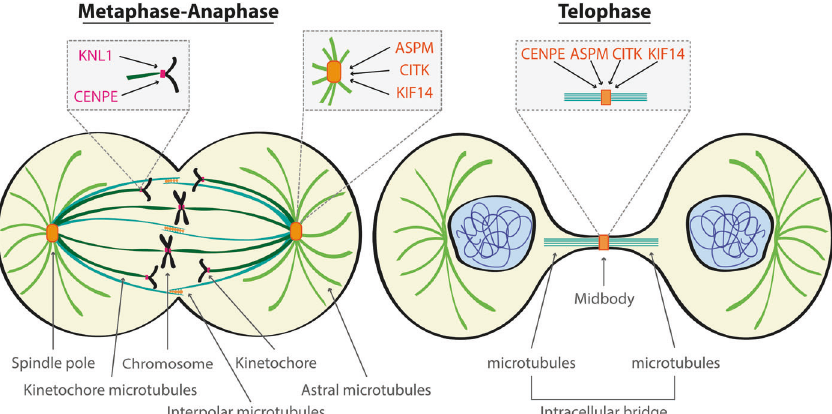
Fig. 1 Scheme of KNL1, ASPM, CENPE, CITK, and KIF14 localization during mitosis. During metaphase, KNL1 and CENPE are localized to kinetochore, where they promote microtubule-kinetochore attachment and correct chromosome alignment. KNL1 and CENPE remain localized to kinetochore up to anaphase. During metaphase-anaphase transition, ASPM, CITK, and KIF14 are found at spindle poles and their associated microtubules. ASPM and CITK are able to interact with astral microtubules and promote their growth. In the transition to telophase, CENPE ASPM, CITK, and KIF14 translocate to the central spindle and then localize at the